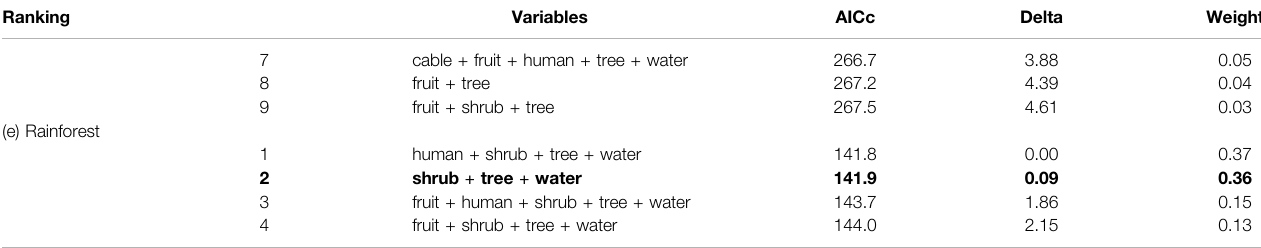
TABLE 2 | ( Continued ) Ranking of the best statistical models which were retained in each con fi dence set, where the Akaike ’ s difference (Delta) with the top-ranked model was less than 5.0, following the Information Theoretic approach, for (a) all habitats and taxa combined, (b) oil palm, (c) subsistence agriculture, (d) village, and (e) rainforest habitats.Themostparsimoniousmodelsareinbold.Weightreferstothecumulativeweightofthemodelsstartingfromthetoprankedmodel.Boldvaluessigni fi es “ Themost parsimonious models ” .